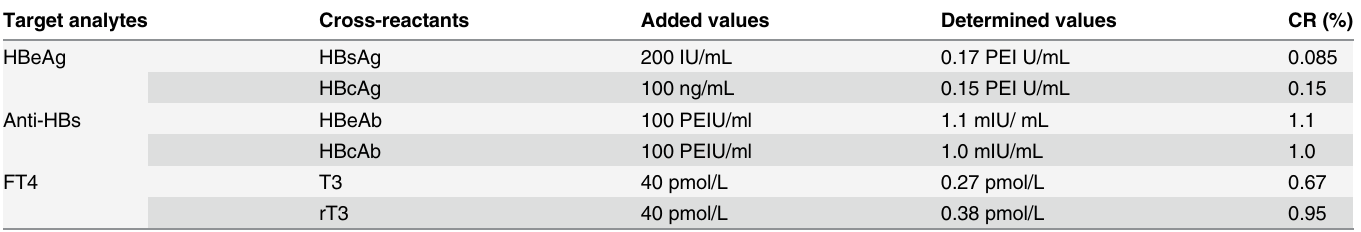
Table 4. Assay specificity: effect of potentially interfering substances on the determination of HBeAg, Anti-HBs and FT4. Target analytes